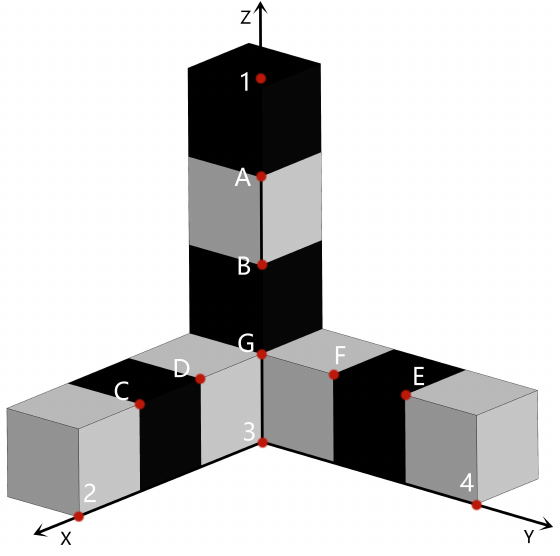
Figure 7. Points selection of first